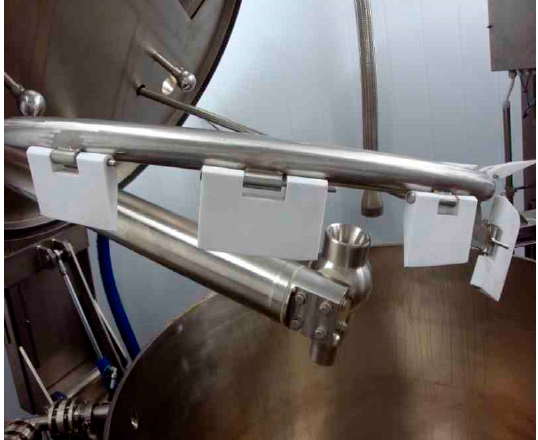
Figure 1. A conventional steam jacketed kettle used to heat batches of food materials. The kettle chamber is typically 1.5 m in diameter with a 1.5 m depth.